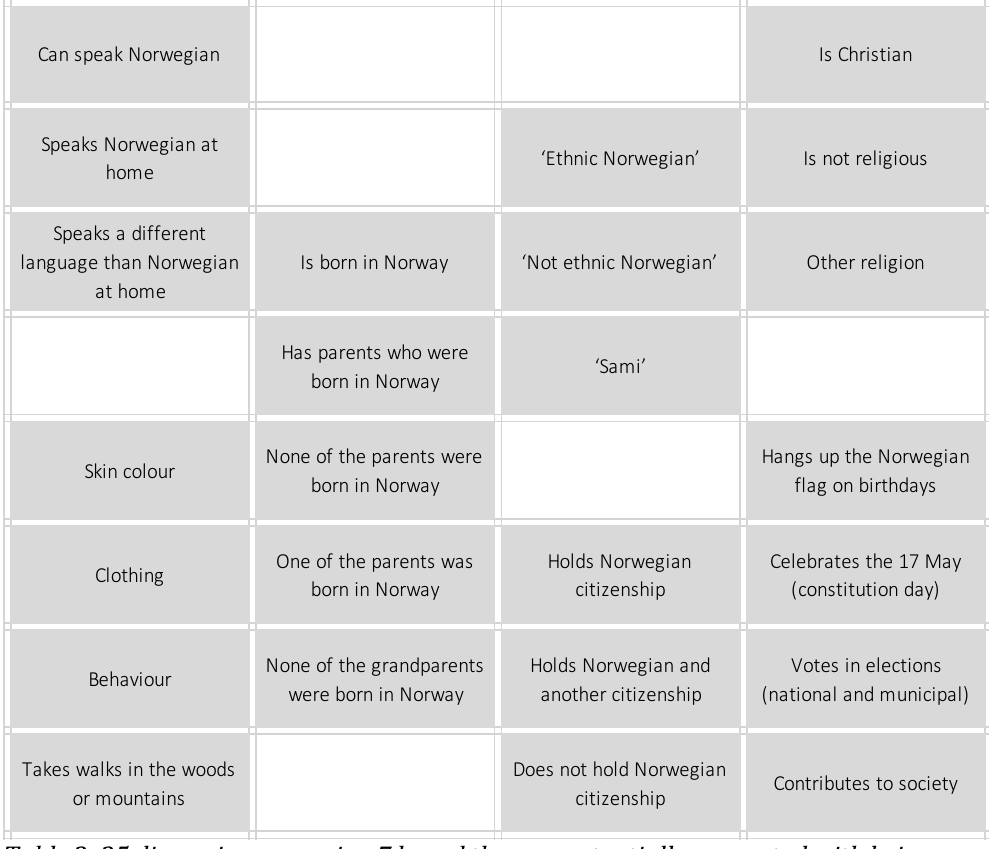
Table 2: 25 dimensions, covering 7 broad themes, potentially connected with being seen as (or not), and feeling (or not) as part of the Norwegian